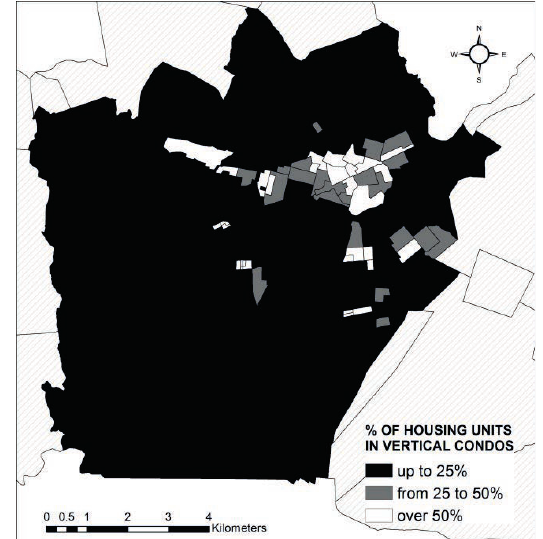
Fig. 5 Housing units in vertical condominiums.